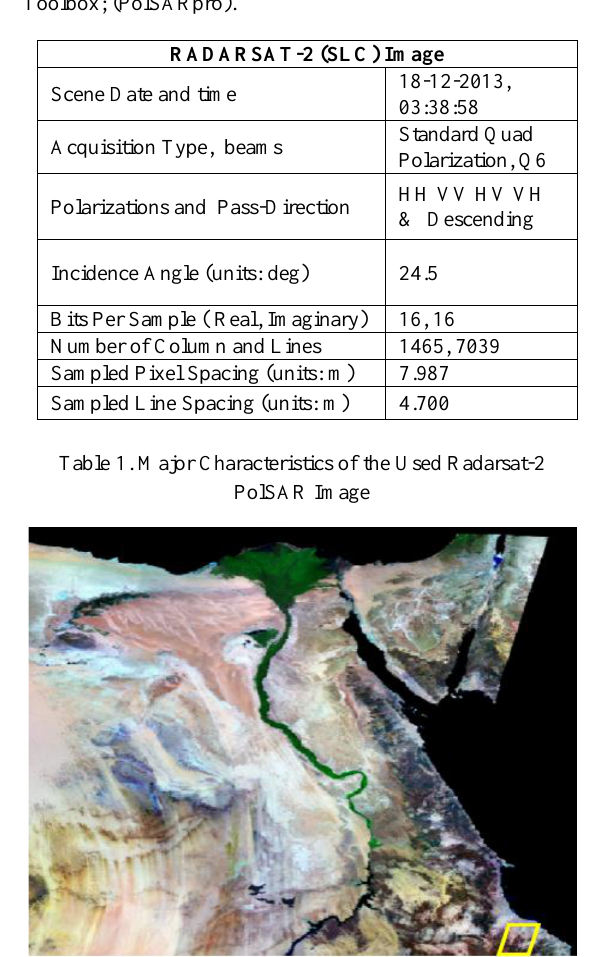
Figure 1. The study area (yellow